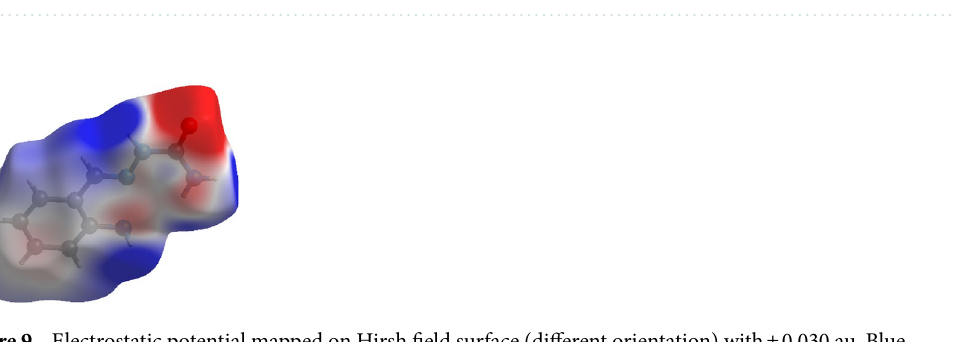
Figure 8. Dnorm mapped on Hirshfeld surface for visualizing the intercontacts of the compound. Color scaled in between − 0.10 au (blue) to 1.21 au (red).